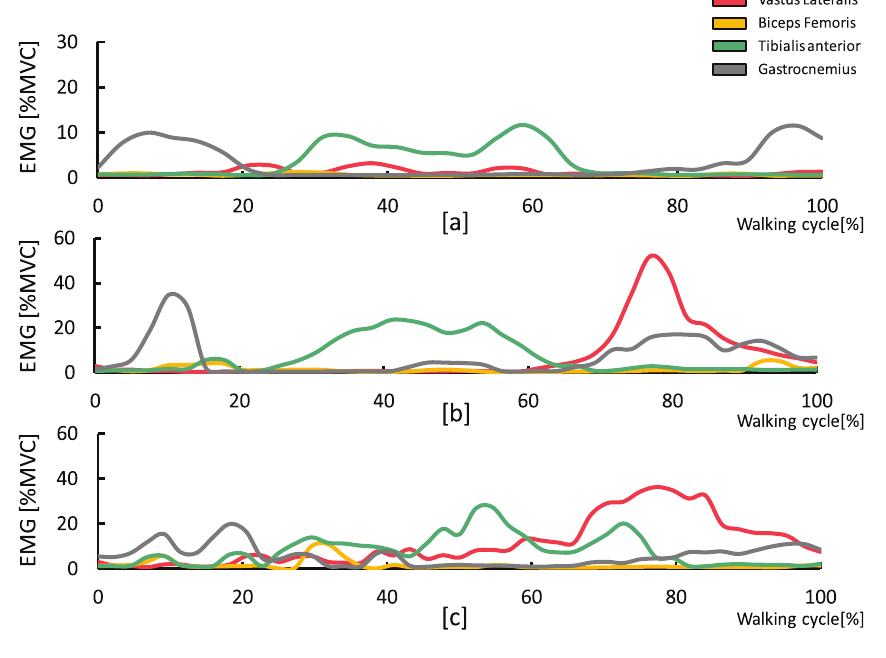
Figure 10. EMG signals of four muscles during a stable walking cycle: ( a ) level walking without feedback, ( b ) stair-climbing without feedback, and ( c ) level walking with visual and force feedback.